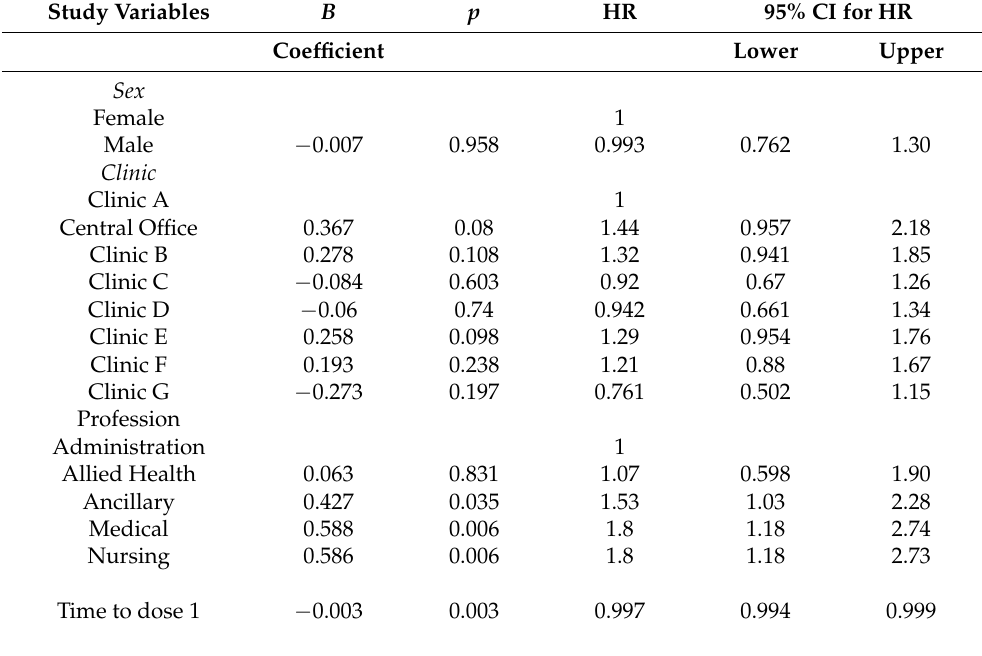
Table 4. Cox regression for time to COVID-19 booster among